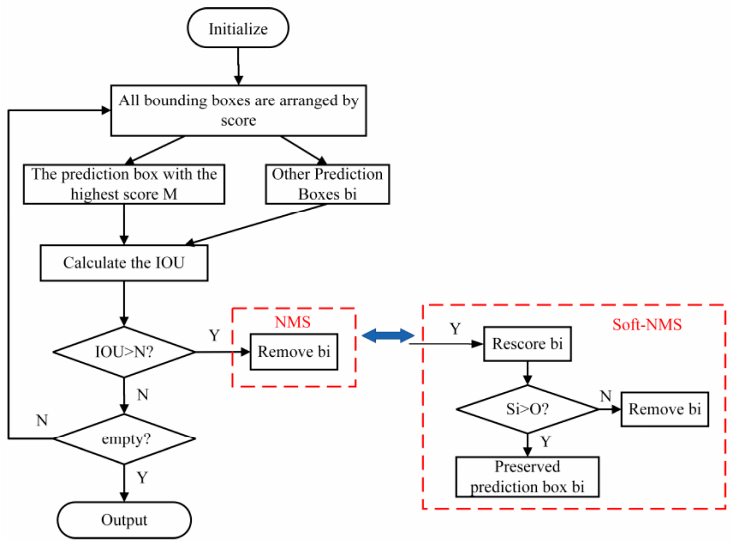
Figure 7. Comparison of NMS and Soft-NMS processes.